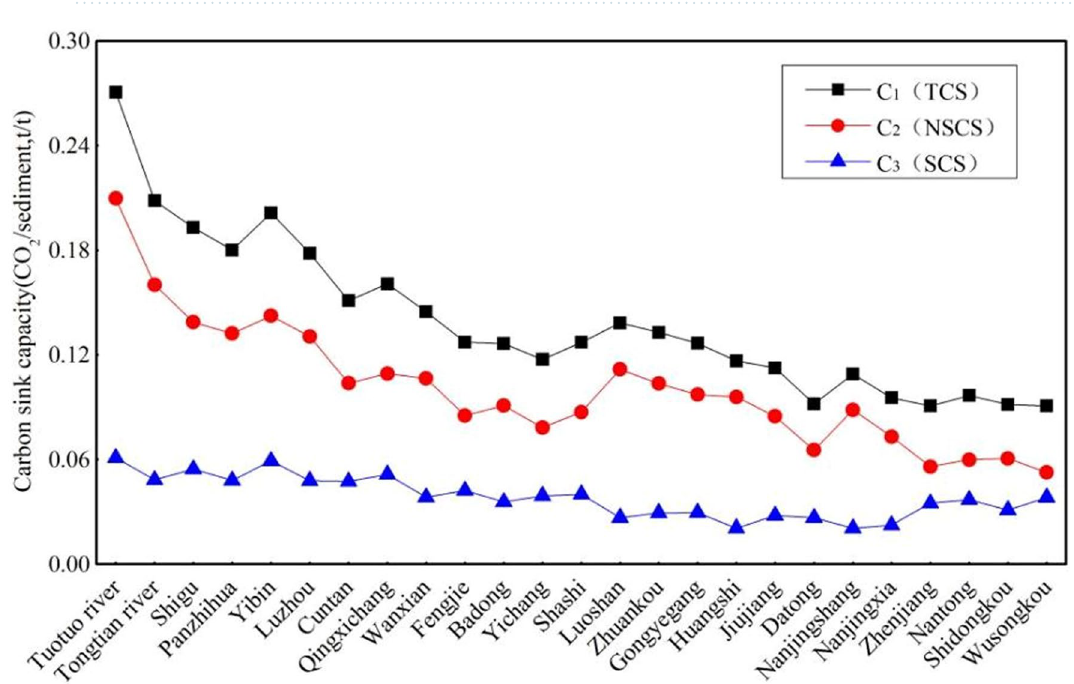
Figure 3. The variation of carbon sink capacities of suspended sediment in the Yangtze